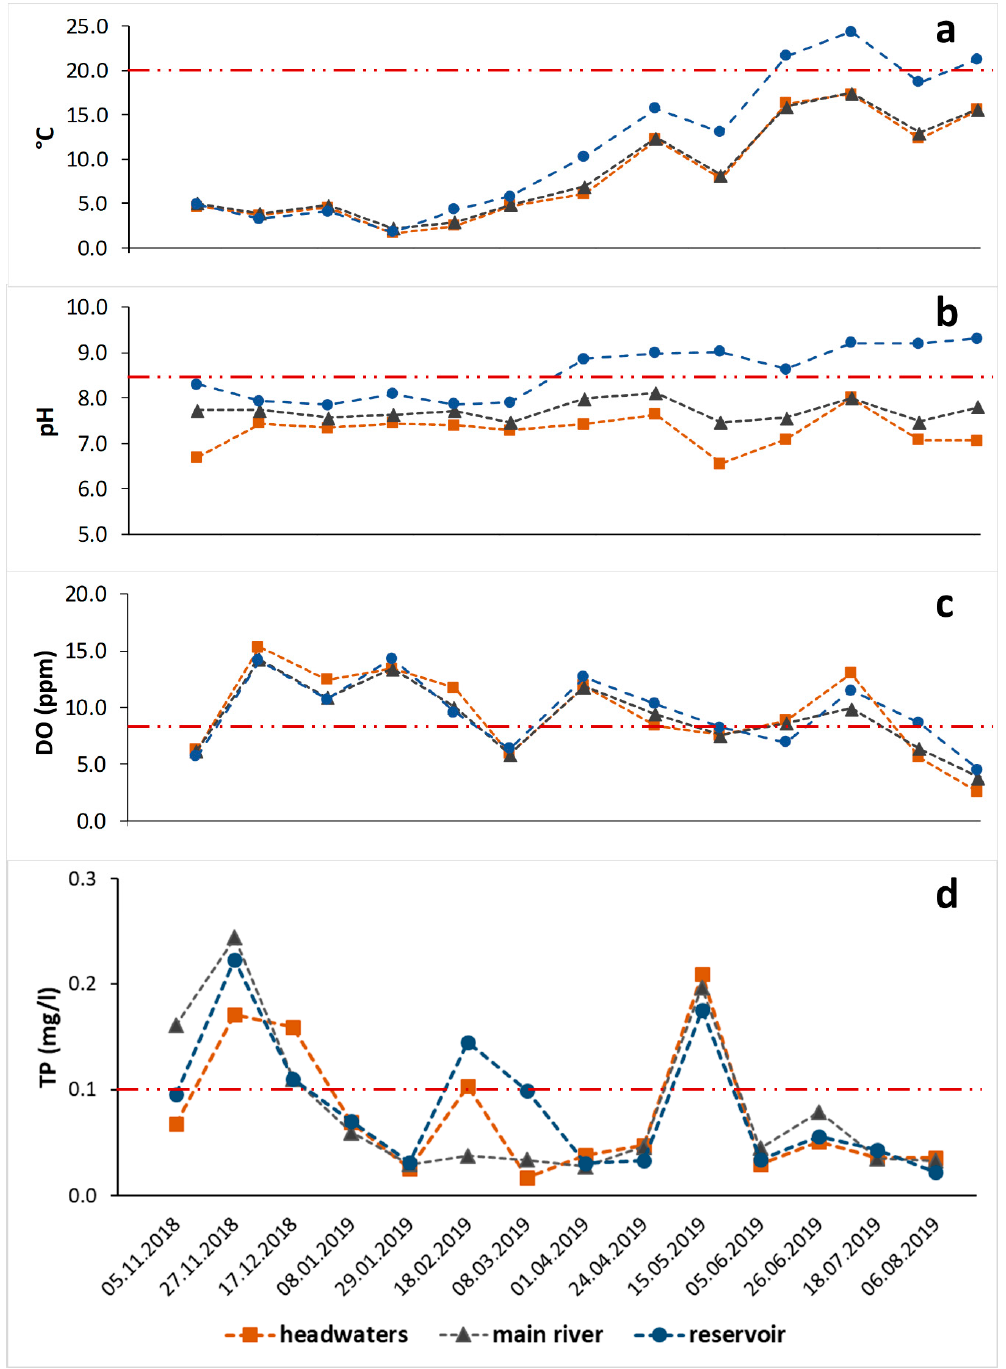
Figure 6. Temporal trends of water quality parameters during the investigation period; means according to types of water bodies (headwaters (n = 2): GOE, OCH; main river (n = 3): AT-1, AT-2, AT-3; reservoir (n = 3): AB-1, AB-2, AB-3). Dashed lines represent thresholds for good ecological status according to Bundesministerium der Justiz und für Verbraucherschutz (2016): ( a ) water temperature, summer maximum; ( b ) pH, maximum; ( c ) dissolved oxygen (DO), minimum; ( d ) total phosphorus (TP), threshold between moderate and poor ecological status (0.1 mg TP/l).